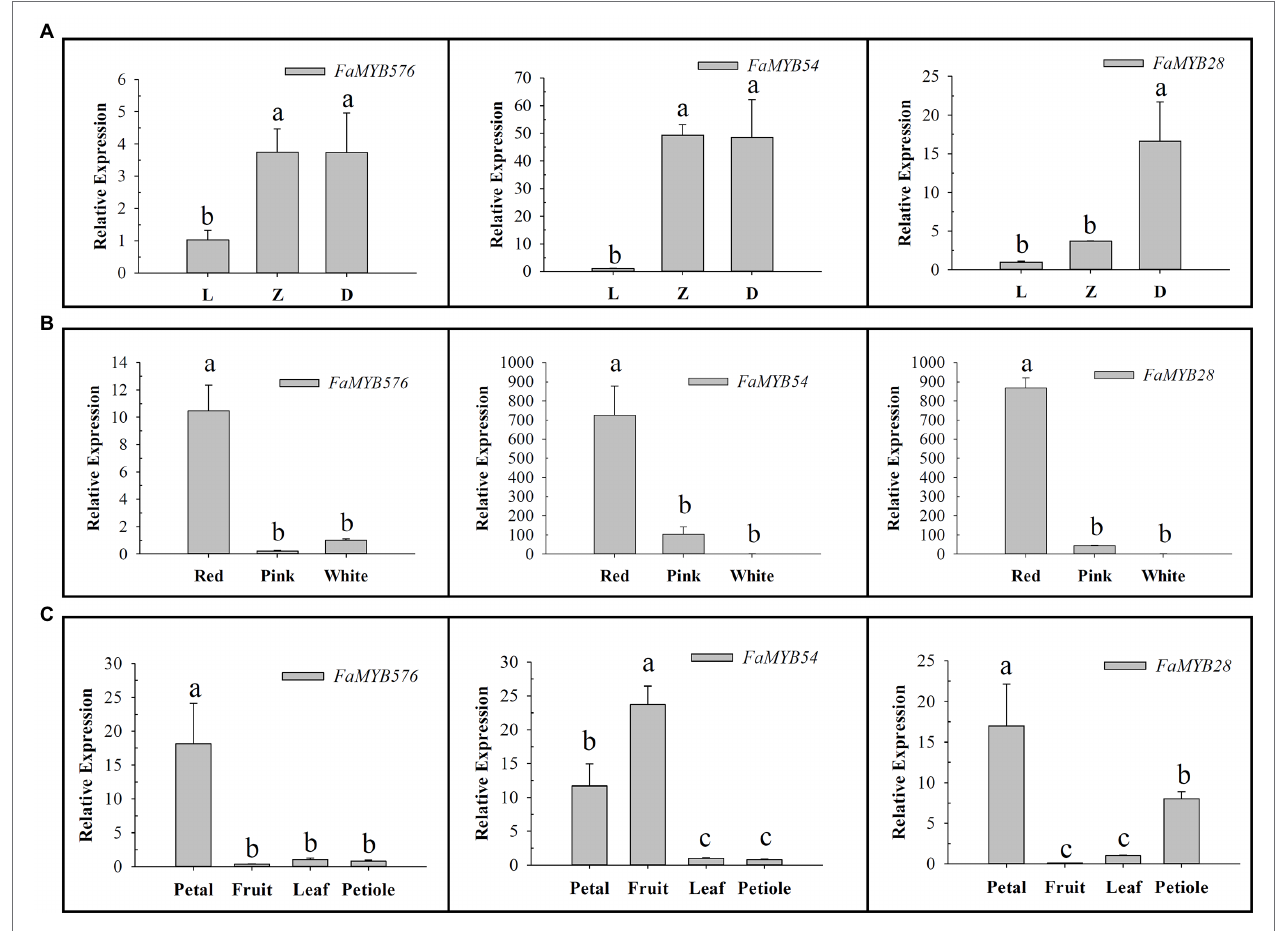
FIGURE 7 | Expression patterns of three anthocyanin-related R2R3-FaMYB genes in pink-flowered strawberry. (A) Expression patterns of three anthocyanin- related R2R3-FaMYB genes in different flower developmental stages (L: Bud stage; Z: Beginning coloration stage; D: Big bud stage). (B) Expression patterns of three anthocyanin-related R2R3-FaMYB genes in different flower colors. (C) Expression patterns of three anthocyanin-related R2R3-FaMYB genes in different tissues. Error bars indicate the mean ± SE of three independent replicates. Different lowercase letters (a, b, and c) are significantly different ( p <